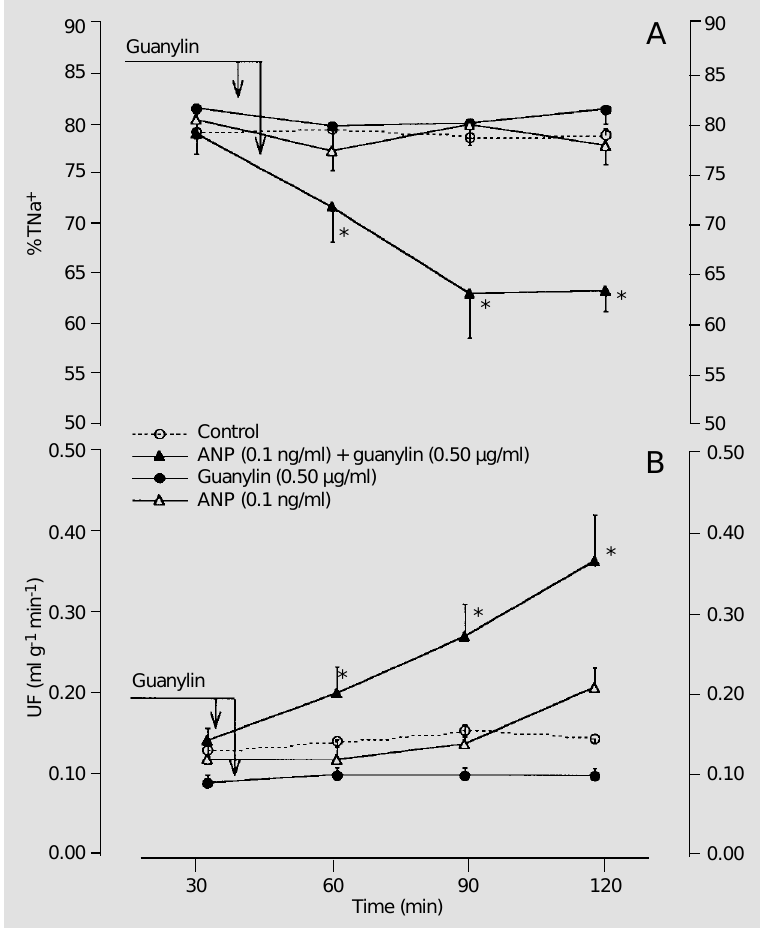
Figure 1 - Diuresis (panel A) and natriuresis (panel B) promoted by guanylin in atrial natriuretic peptide (ANP)-pretreated kidneys. Note that at 60, 90 and 120 min after ANP perfusion, guanylin increased urine flow (UF) and decreased fractional sodium transport (%TNa + ). Data are reported as means ± SEM; N ‡ 9; *P<0.05 compared to control (ANOVA and